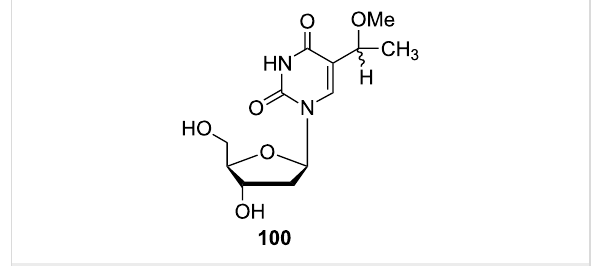
Figure 14: 5-(1-Methoxyethyl)-2'-deoxyuridine 100 .